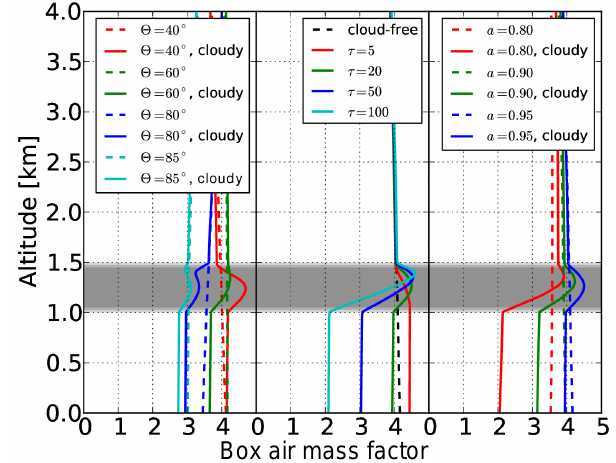
Figure 1. Radiative transfer simulations showing sensitivity of satellite observations to BrO in the boundary layer under (dashed lines) cloud-free and (solid lines) cloudy conditions. The panels show the influence of (left) solar zenith angle θ , (middle) cloud opti- cal thickness τ and (right) surface albedo a on the box air mass fac- tor. All simulations are at a wavelength of 350nm, θ = 50 ◦ , τ = 20, and a = 0 . 9 unless noted